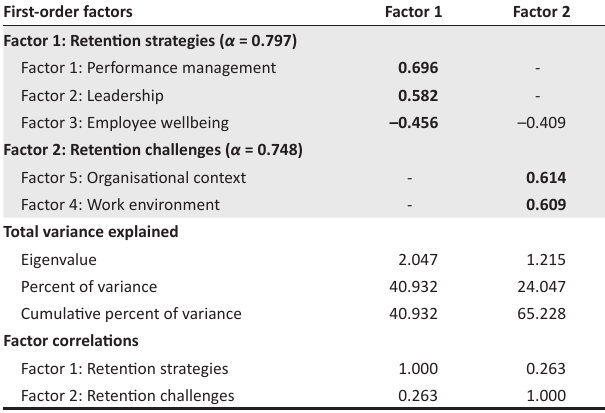
TABLE 2: Second-order factor loadings for Oblimin with Kaiser Normalisation two-factor solution.